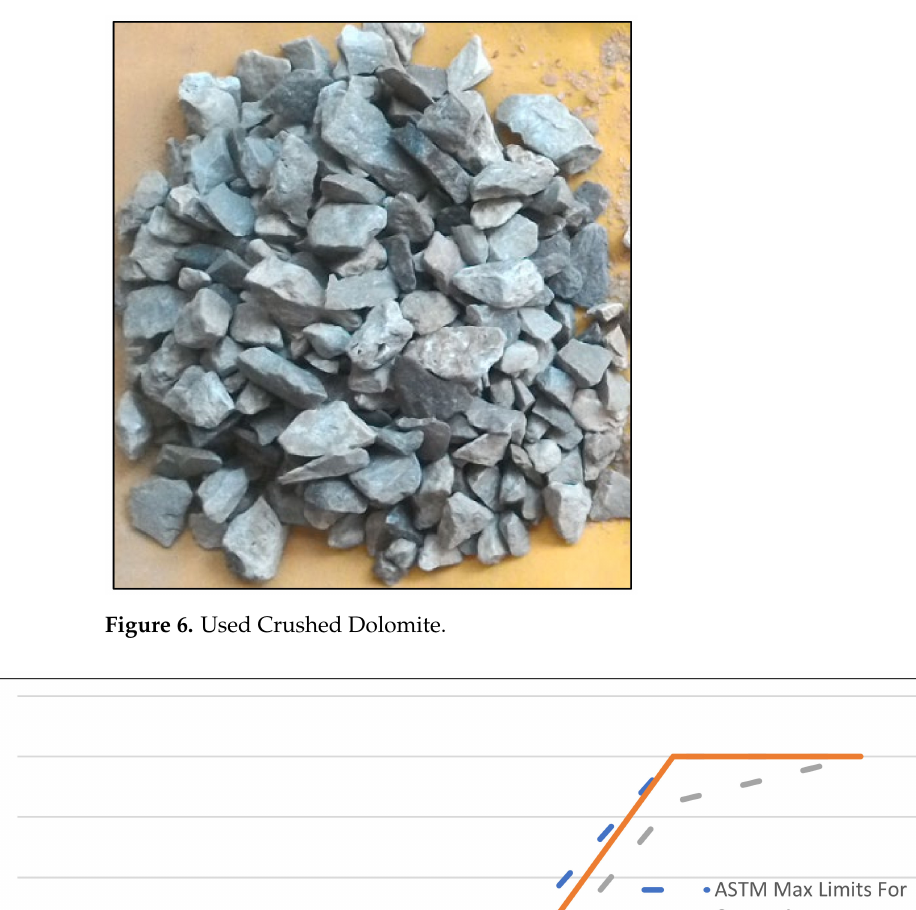
Figure 5. Normal sand grading [41].